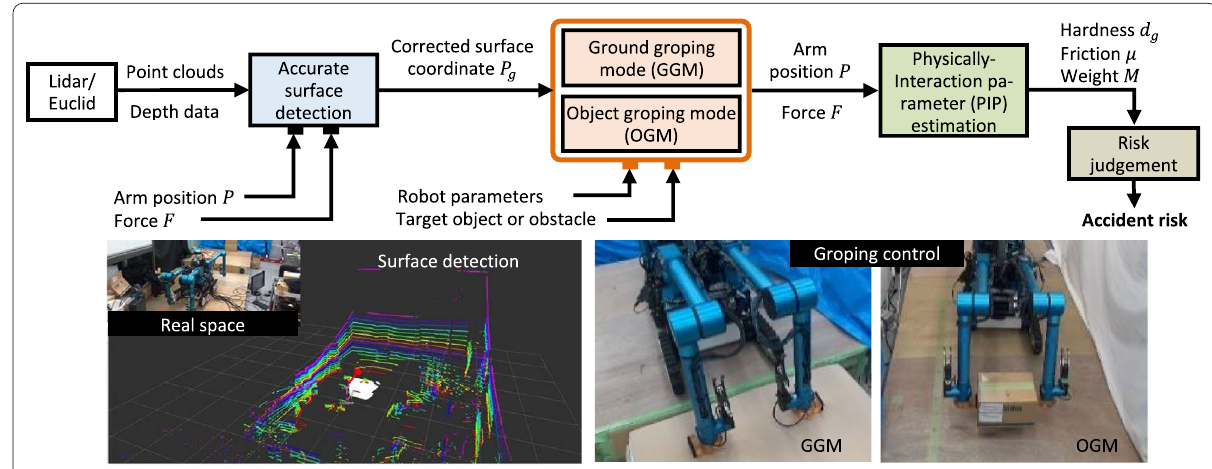
Fig. 3 System diagram of physically interactive parameter and risk